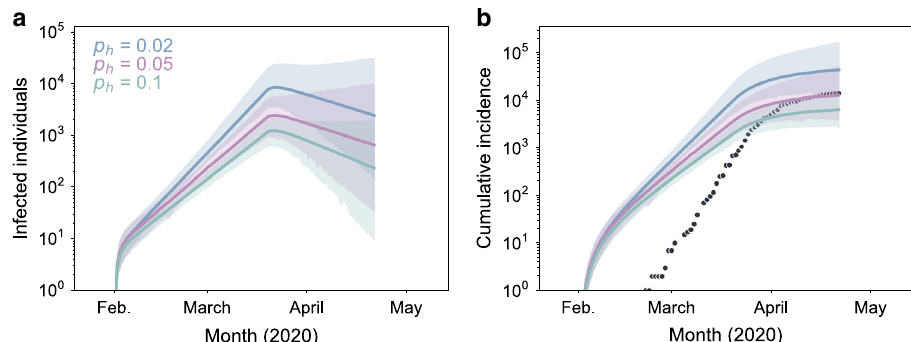
Fig. 6 Epidemiological dynamics inferred using phylodynamic analysis. a Estimated number of currently infected individuals ( I l + I h ) over time. b Estimated cumulative number of infected individuals. An infected individual is assumed to contribute to cumulative incidence at the end of their infectious period. Black dots show the cumulative number of reported cases in Israel over time. In a and b , lines show median estimates of models with different levels of transmission heterogeneity. Shaded regions represent the 95% highest posterior density region. Source data are provided as a Source Data fi le.